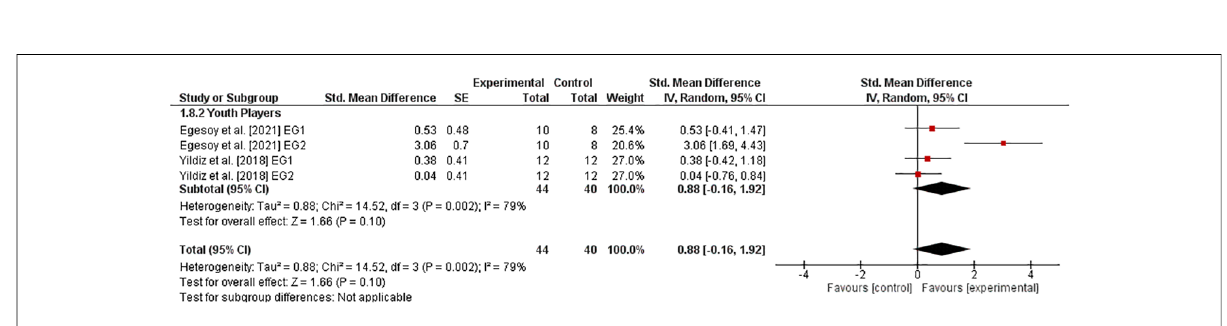
FIGURE 8 Effects of athletic training on measures of balance (e.g., Y balance test) in healthy youth tennis players. CI =con fi dence interval, df =degrees of freedom, SE =standard error, IV =inverse